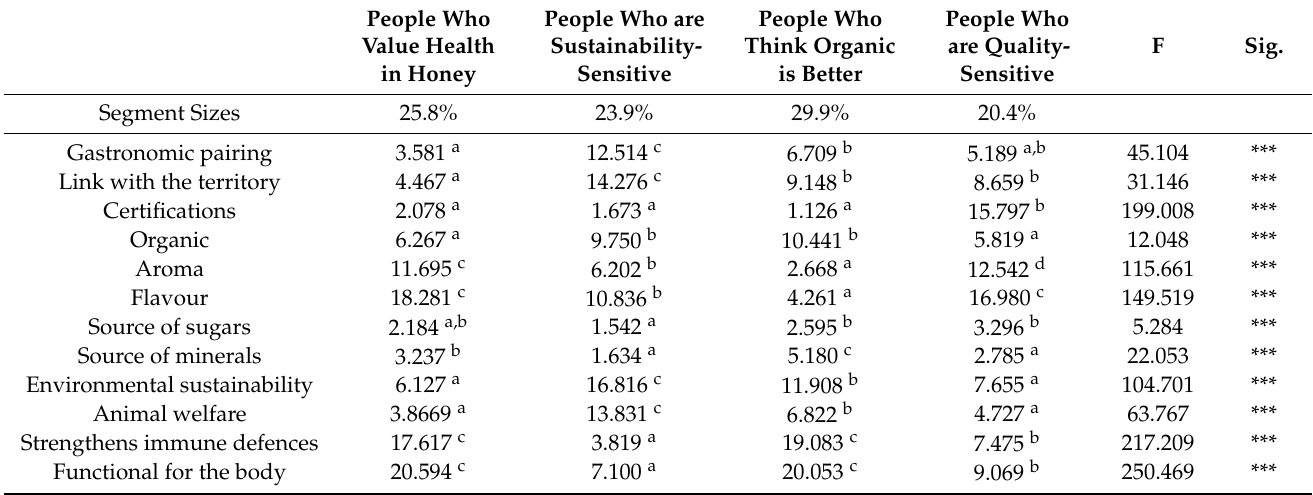
Table 4. Characterisation of clusters based on segmentation variables (probability scale: 0–100 Rescaled Score